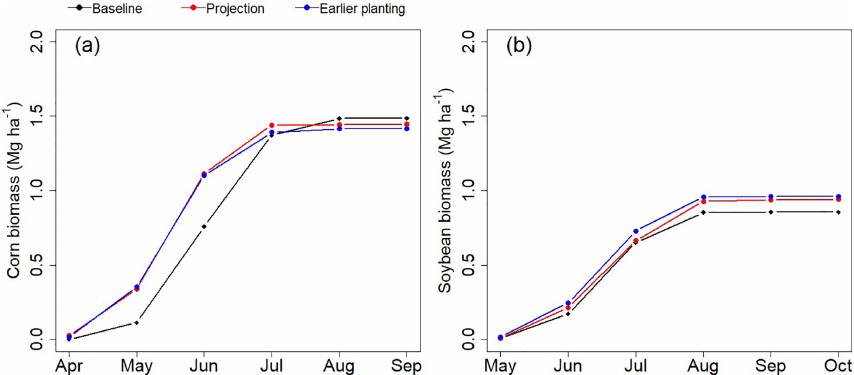
Figure 9. Crop biomass growth under the baseline and GCM scenarios: (a) corn and (b) soybean. Note: “Projection” stands for the simulated biomass planted on the original planting dates under the GCM scenario. Earlier planting indicates the simulated biomass planted 10 days earlier than the original planting dates under the GCM